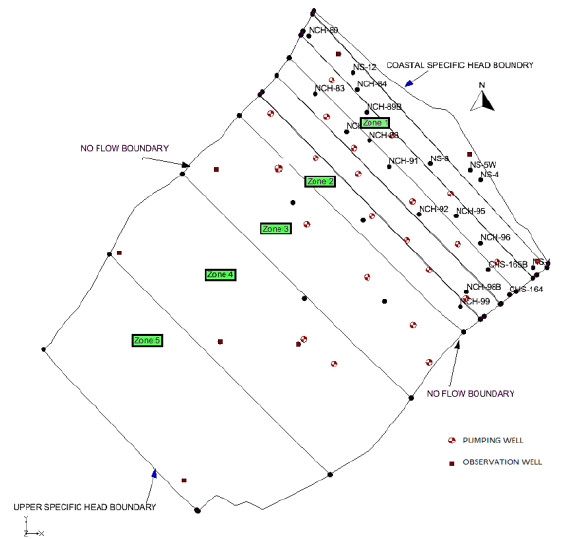
Figure 4. Location of salinity monitoring wells and zones in the model domain.